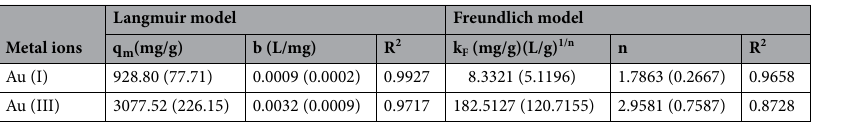
Table 2. Comparison of the Langmuir and Freundlich parameters for the adsorption of Au (I) and Au (III) onto PEIIAC. Standard errors are present in parentheses.